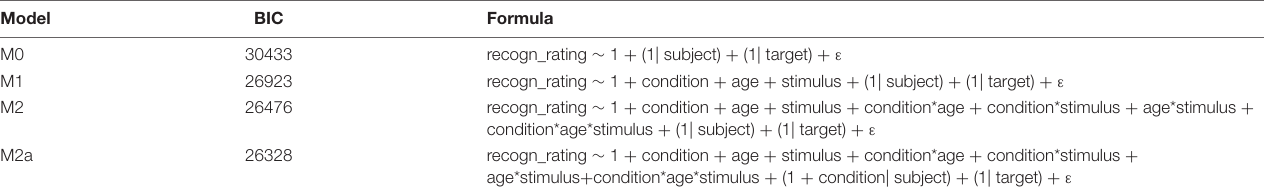
TABLE 7 | Linear mixed-effects models for recognition memory rating as measured on a 5-point scale (–2 “sure new,” –1 “probably new,” 0 “undecided,” 1 “probably old,” and 2 “sure